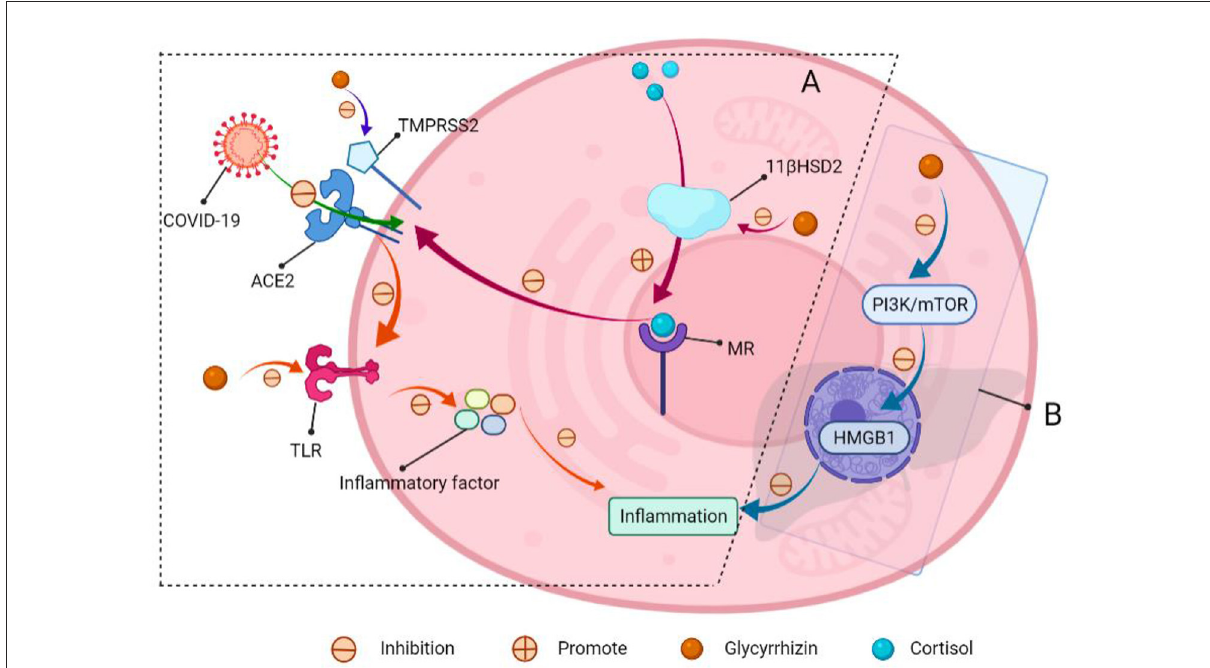
FIGURE9 Schematic of glycyrrhizin for COVID-19 resistance and acute hepatitis therapy. (A) COVID-19 entry into the cells through ACE2. (I) The mineralocorticoid receptor (MR) regulates ACE2 expression, and MR activation decreases ACE2 expression. Meanwhile, glycyrrhizin promotes cortisol activation of MR by inhibiting 11- β -hydroxy steroid dehydrogenase 2 (11 β -HSD2), lowering ACE2 expression and preventing virus entry into cells; (II) transmembrane protease serines TMPRSS2 (which is a cofactor that promotes viral entry into cells through ACE2). Glycyrrhizin suppressed the expression of TMPRSS2; (III) ACE2 can produce angiotensin, which inhibits TLR4 receptor expression. Meanwhile, glycyrrhizin can directly block TLR4 receptors, preventing the production of inflammatory factors and lowering lung inflammation. (B) Glycyrrhizin relieves acute